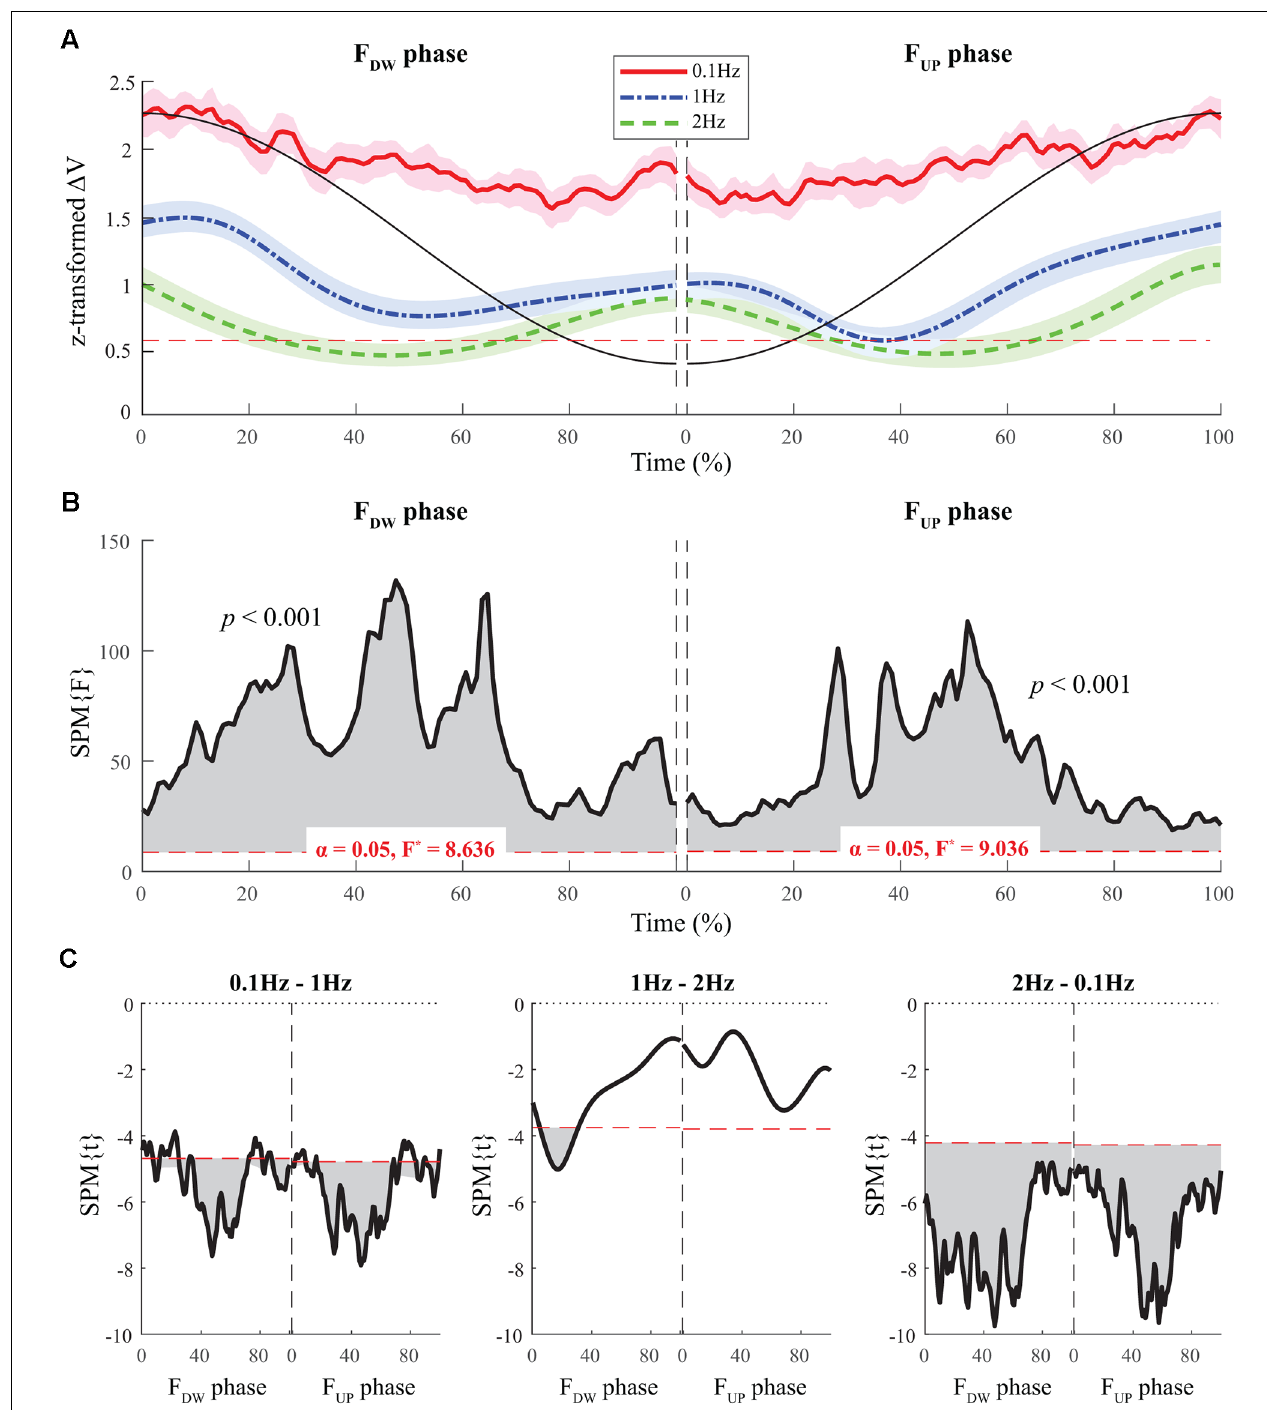
FIGURE 3 | The sample data of total force (black solid line) and the time profiles of averaged ∆ Vs across participants for three frequency conditions are presented with standard deviations shades during the F DW ( left panel ) and F UP ( right panel ) phases. Red solid-, blue dashed-single dotted-, and green dashed lines present ∆ V time-profiles for 0.1, 1, and 2 Hz, respectively. The horizontal dotted line in red color indicates a critical value of z -transformed ∆ V (i.e., per-dimensional V UCM equals V ORT ), which determines the existence of the synergy (A) . Statistical parametric mapping SPM{F} trajectories on ∆ Vs (black solid line) with repeated measures analysis of variance (ANOVA) are presented for the F DW ( left panel ) and F UP ( right panel ) phases. The horizontal dotted line in red color indicates the threshold of critical random field theory at α = 0.05 (B) . Post hoc pairwise t -tests (SPM{t}) on ∆ Vs are presented. The horizontal dotted lines in red color indicate the threshold of critical random field theory at p < 0.05 (C) .